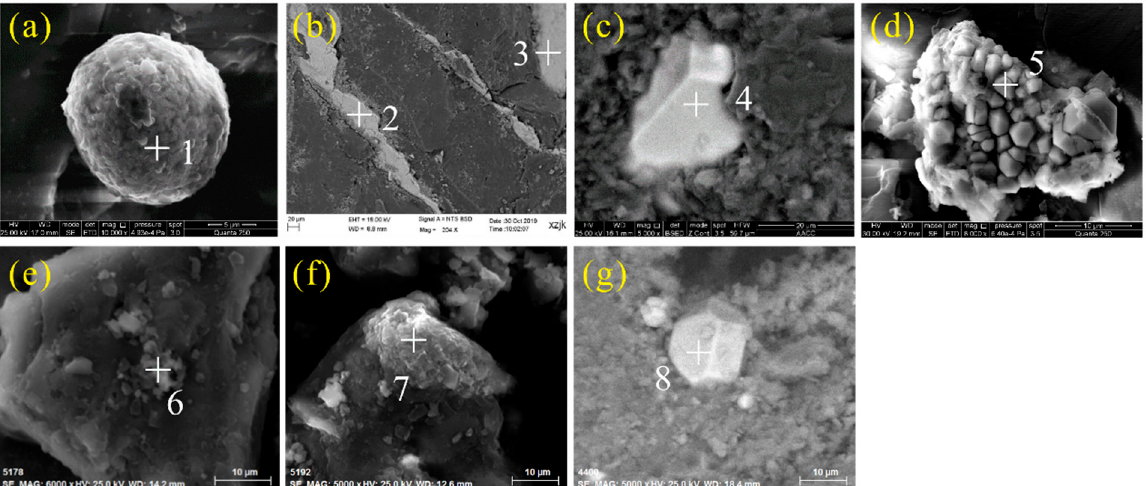
Figure 4. Occurrence forms of pyrite in coal samples: ( a ) is the framboidal pyrite (site 1); ( b ) is the fissure-filled (site 2) and aggregated massive pyrite (site 3); ( c ) is the euhedral crystalline pyrite (site 4); ( d ) is the caviar-like pyrite (site 5); ( e ) is the Fine-grained agglomerated pyrite (site 6); ( f ) is the aggregated massive pyrite (site 7); ( g ) is the euhedral crystalline pyrite (site 8).